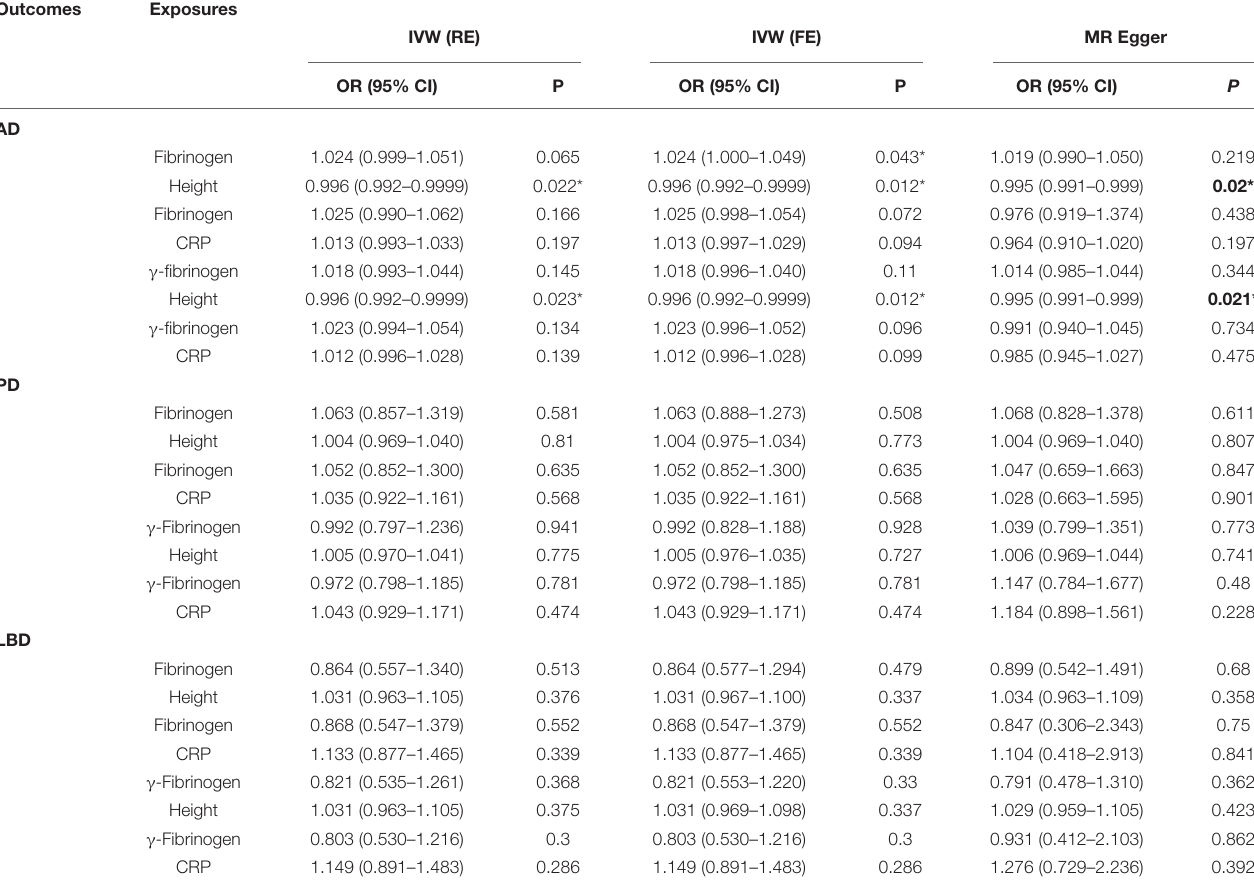
TABLE 1 | Results of multivariable MR adjusting for the effect of height and CRP.